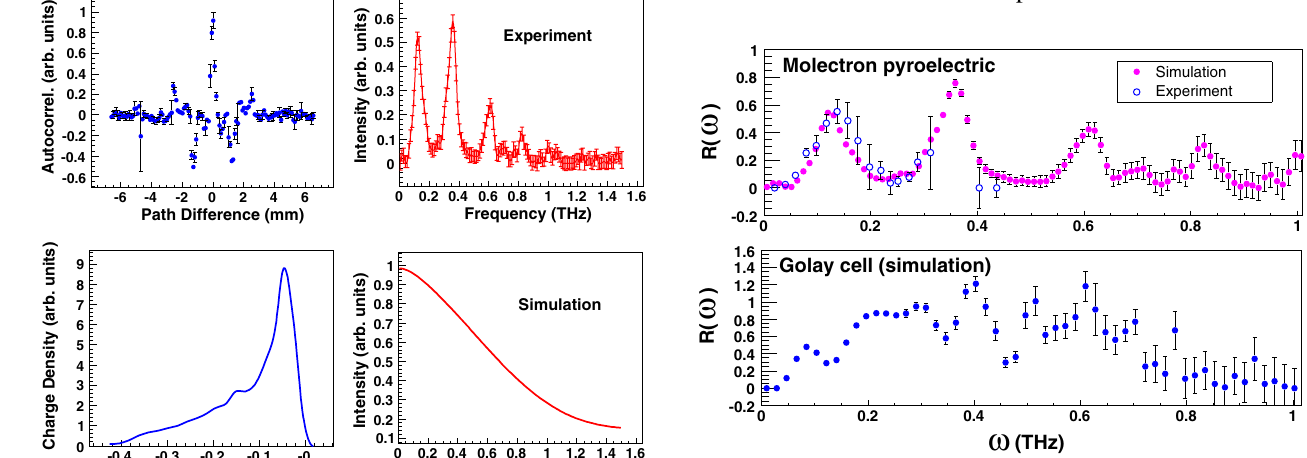
FIG. 2. (Color) Top plots: measured autocorrelation and inten- sity spectrum for 0.5 nC electron bunches at maximum com- pression. These measurements were performed with pyroelectric detectors following the procedure described in Sec. IV. Bottom plots: simulation results for longitudinal charge density and intensity spectrum also for 0.5 nC electron bunches at maximum compression.